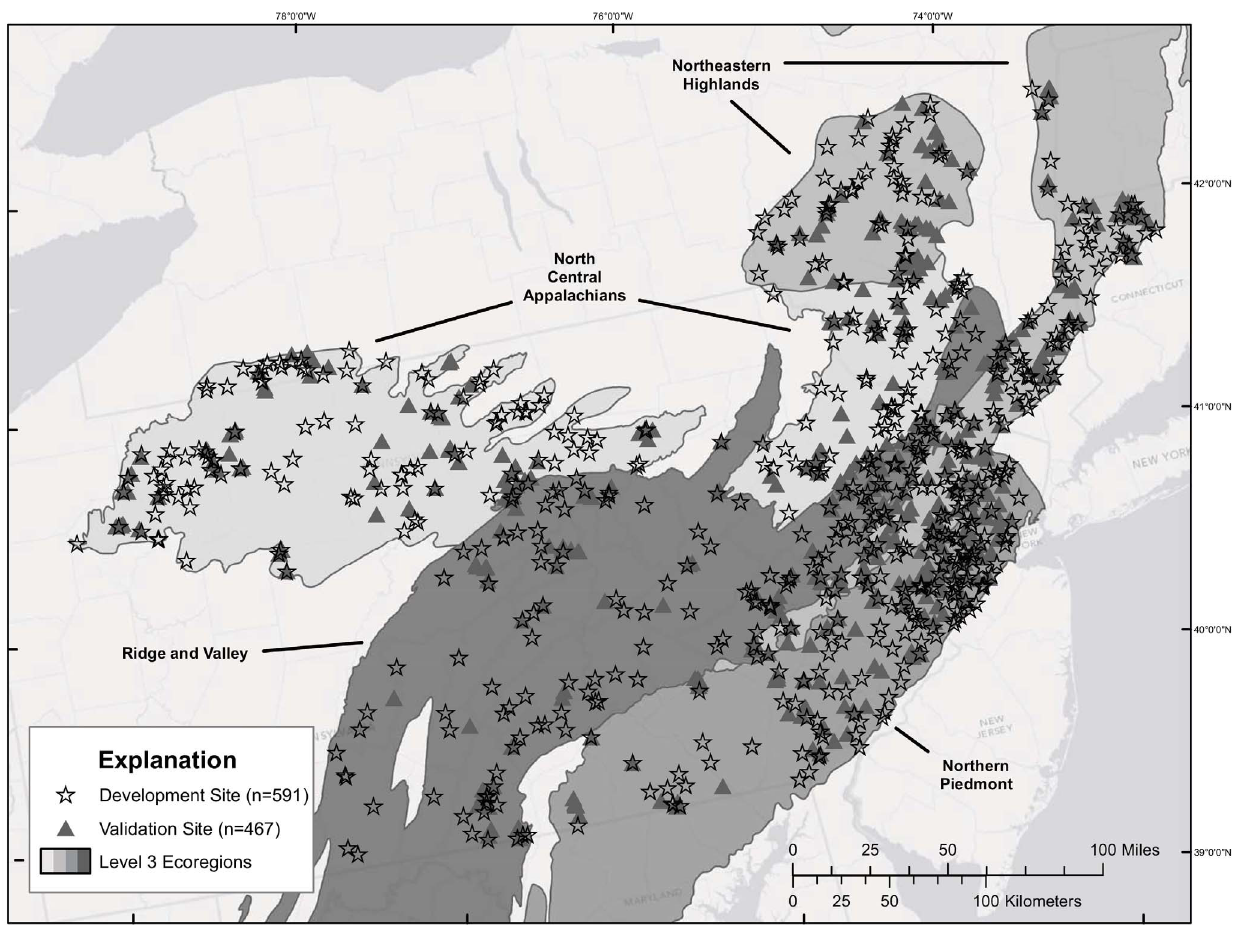
Figure 1. Map showing the stream sites used for model development (stars) and model validation (triangles). Sites used for model development (stars) (n=591) and model validation (triangles) (n=467) are evenly spread across the four ecoregions used in this study (N.C. Appalachian, Ridge and Valley, N.E. Highlands and N. Piedmont).